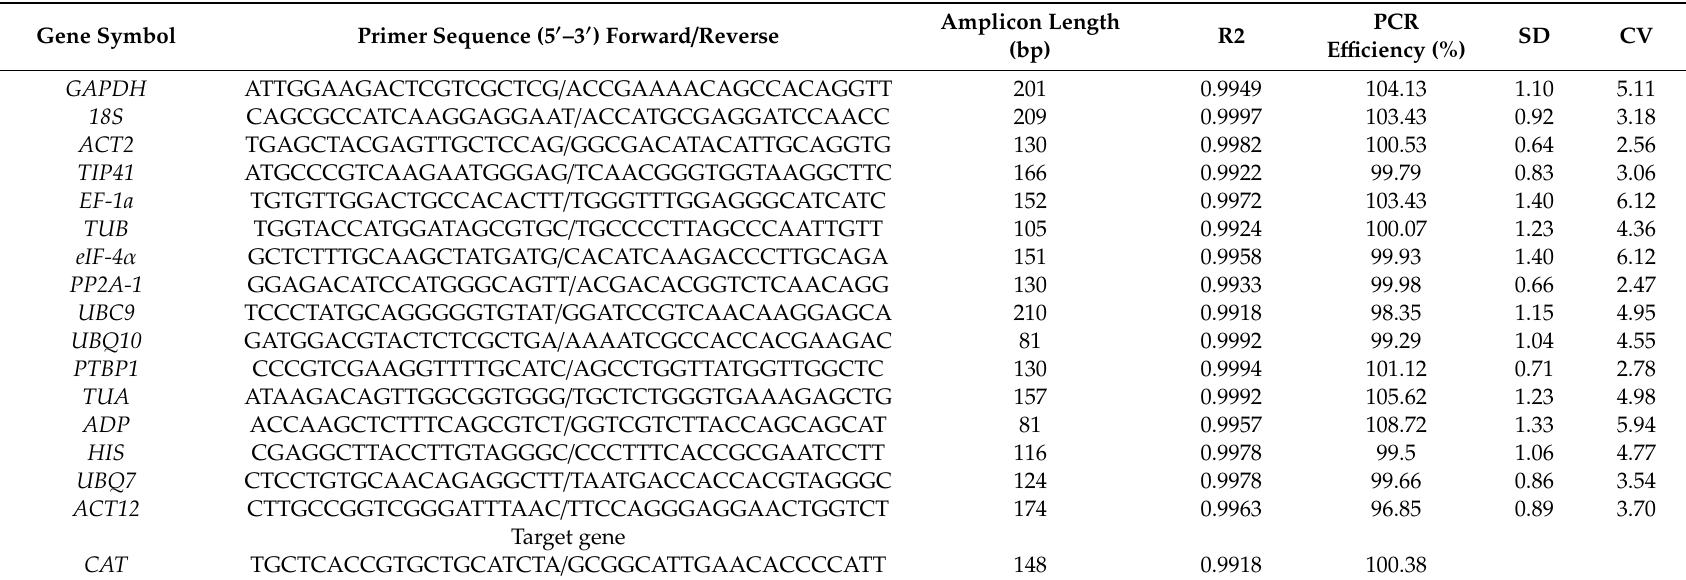
Table 2. Primers, amplicon characteristics and qRT-PCR parameters for candidate reference genes and target